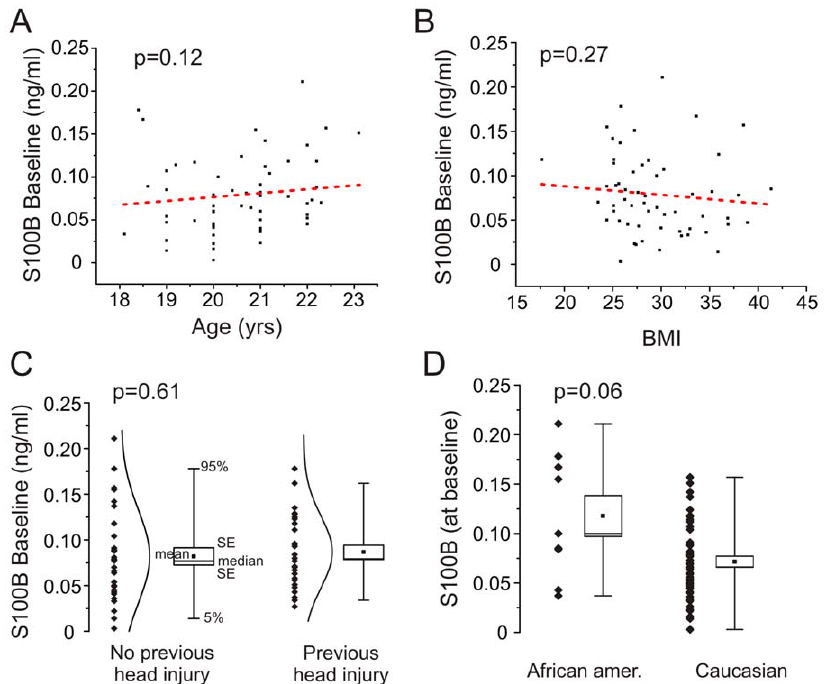
Figure 1. Demographics of the Cleveland players enrolled in the study. Please also see Table 1 and Table S1. S100B serum levels measured at baseline (prior to any games) where independent from age ( A ) and body mass index ( B ). History of previous concussion did not affect S100B baseline values ( C ). Baseline S100B levels were higher in African-American compared to other races ( D ).